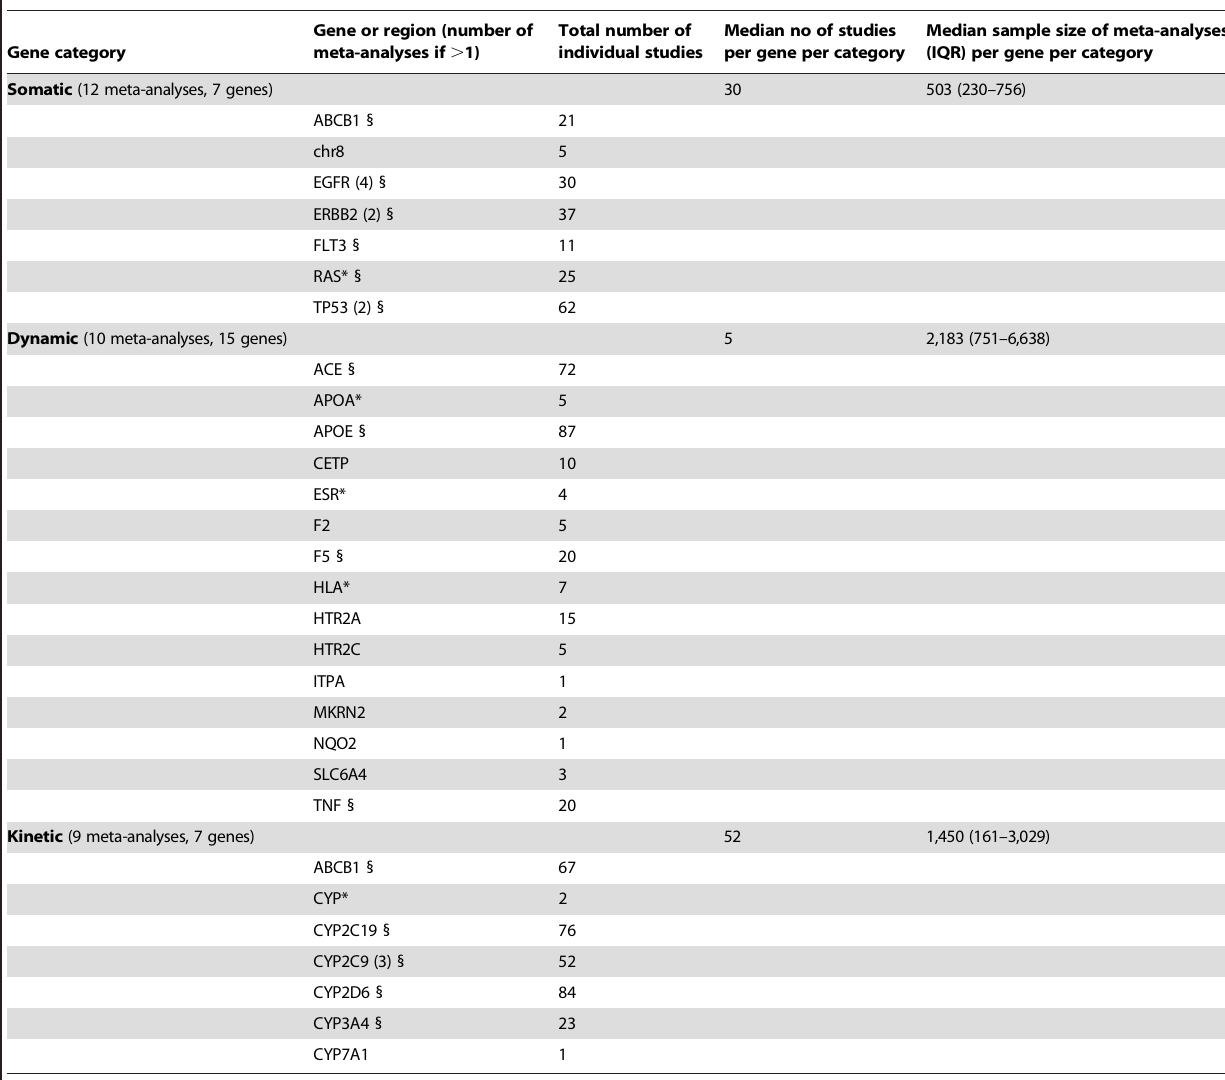
Table 2. Summary of meta-analyses of pharmacogenetic studies.